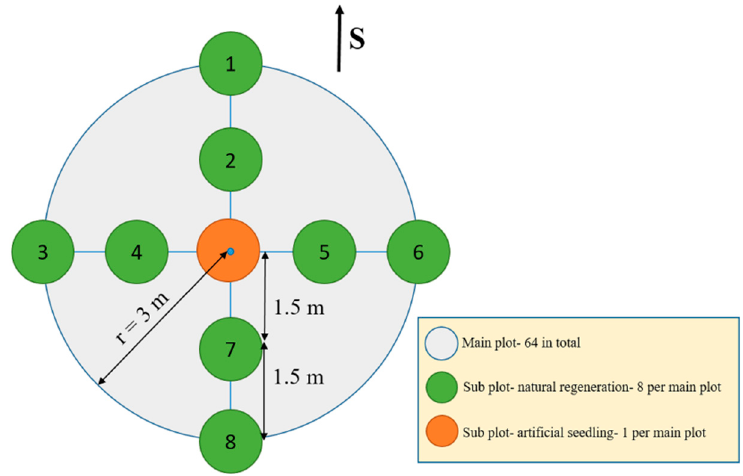
Figure 4. The plots’ and sub-plots’ position and size.